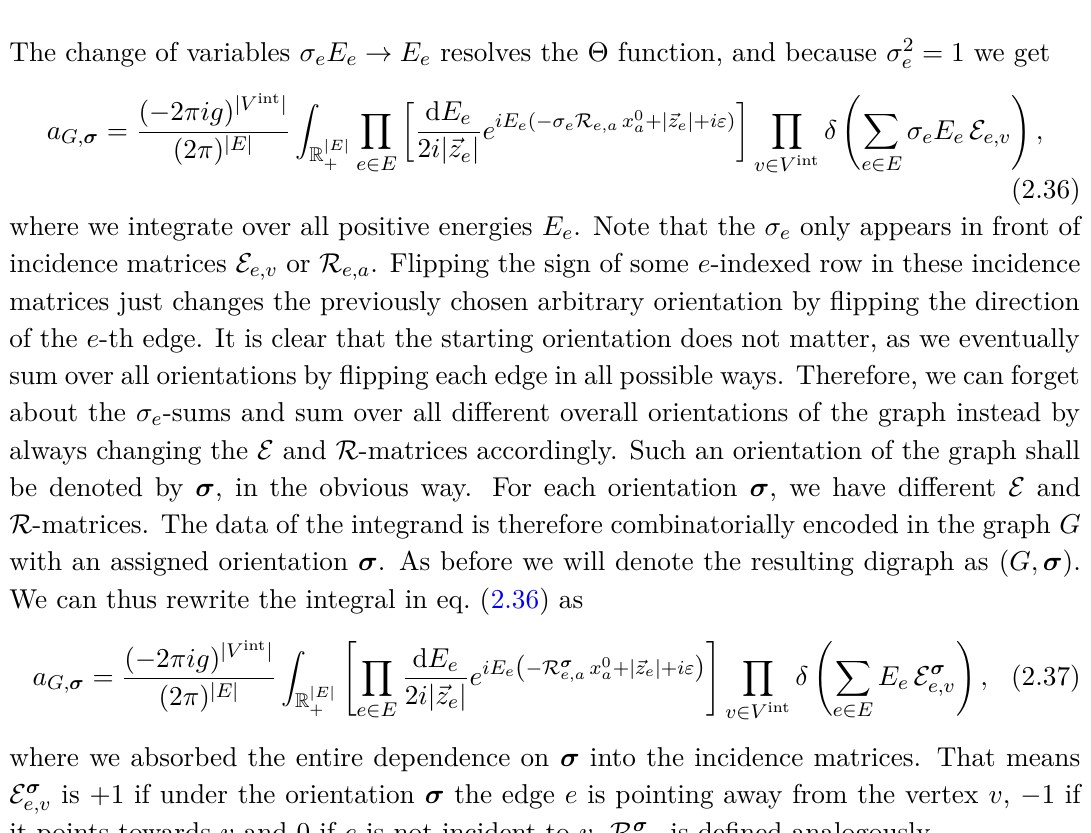
Figure 1. Illustration of the completed graph G ◦ that is obtained after adding the artificial vertex ◦ at